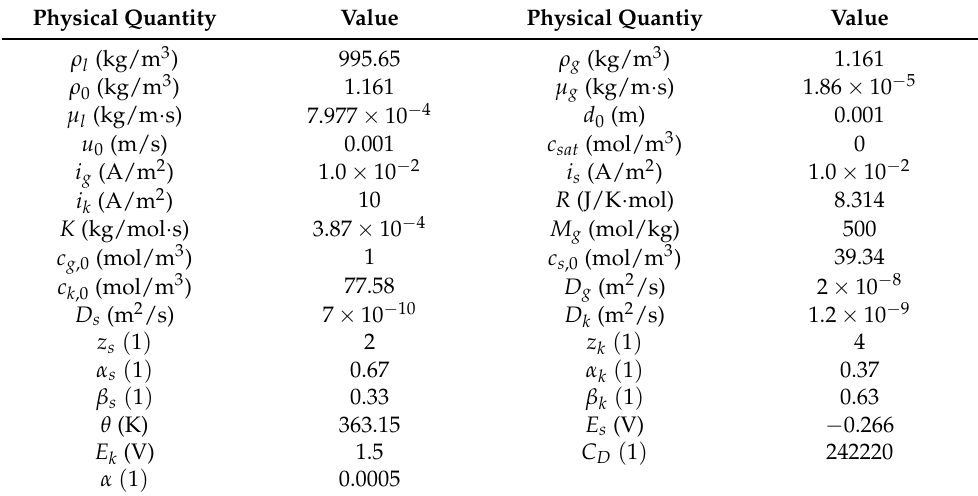
Table 3. Parameters used in Section